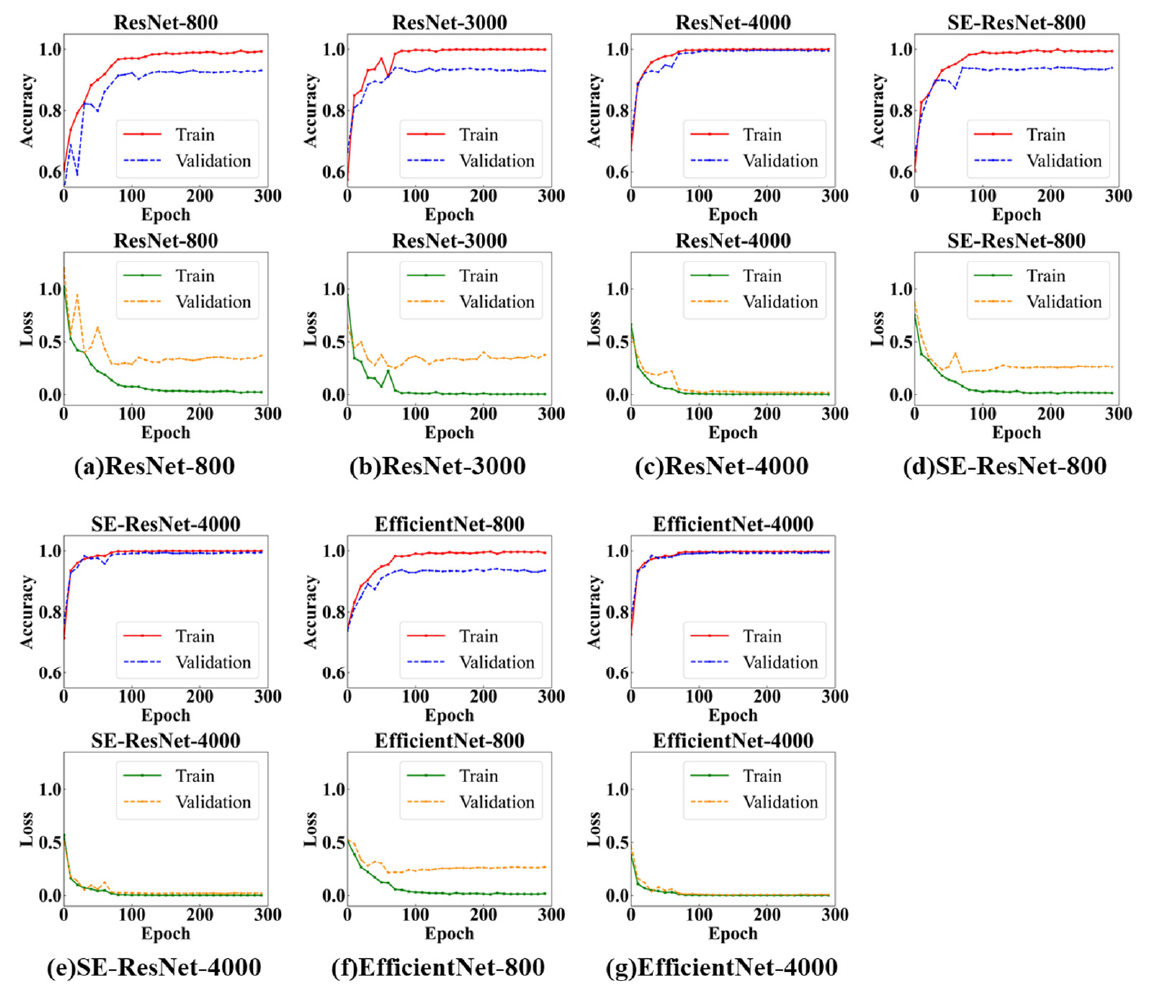
Figure 12. Simulation results of each model. The number after the model name indicates the number of training datasets.